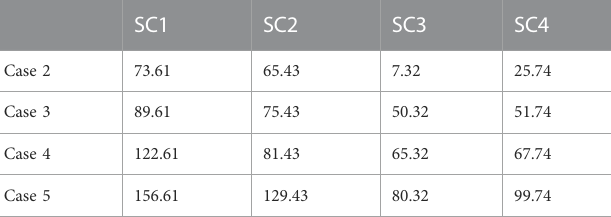
TABLE 2 Daily cost reduction for different cases from base